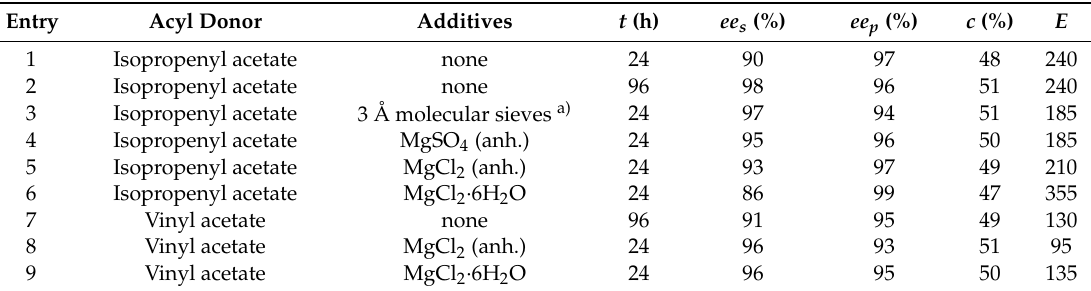
Table 2. CAL-A-catalyzed (NZL-101-IMB; 60 mg / mL) acylation of rac - 1 (5.0 mM) with